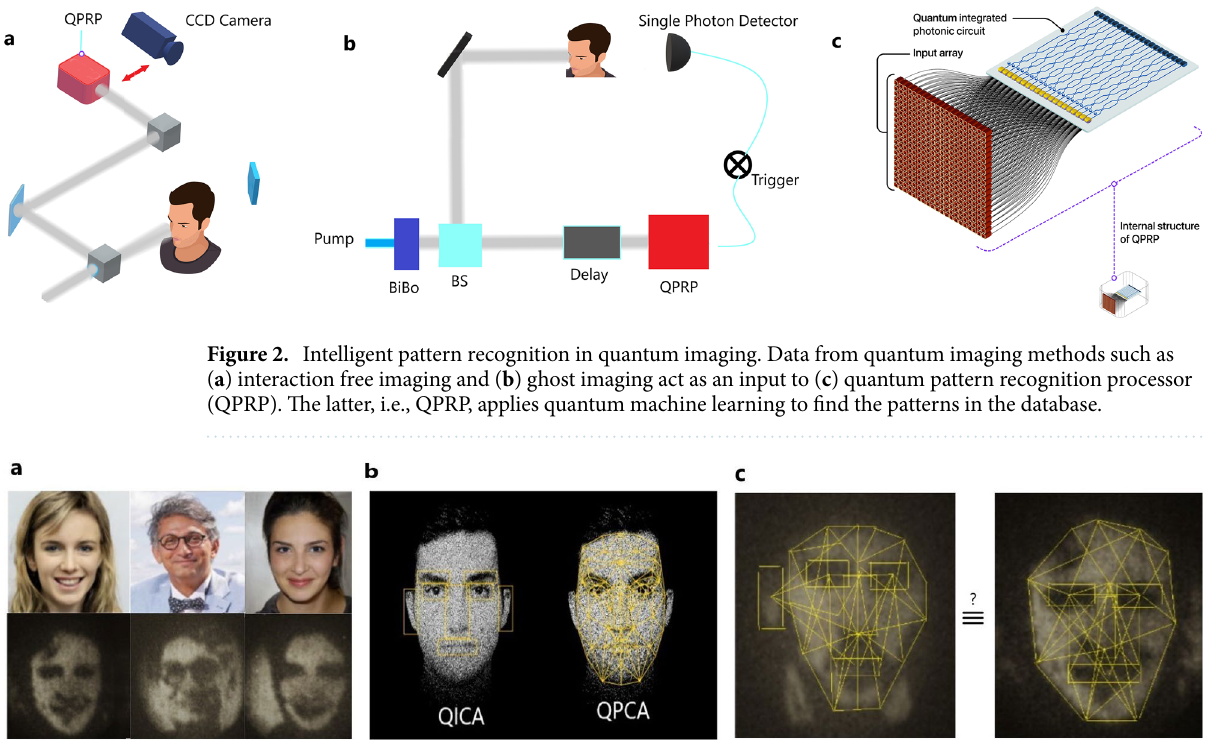
Figure 3. Face recognition in ghost images. ( a ) Images of the original human faces (top) and the corresponding experimental ghost images (bottom) obtained in a ghost imaging setup. A femtosecond laser is used to generate spatially entangled photon pairs. One of the photons illuminates a spatial light modulator, which imprints different images onto the photon, and can act as a trigger for the other photon that was detected by an intensified CCD camera. Each of the images was obtained by the accumulation of 300 frames with an exposure time of 0.5s, which translates to a run time of 150s. ( b ) Quantum Independent Component Analysis (QICA), and Quantum Principal Component Analysis (QPCA), of the faces to detect the independent components, and principal features in the faces. ( c ) Dissimilarity measure between the ghost images with the images in the database for their identification. As per the copyright policies of the journal, in this illustration we use artificially generated faces (the first and the third) from the website https:// www. thisp erson doesn otexi st. com. For the second figure, the coauthor provided the required consent for both the experiment and use in the